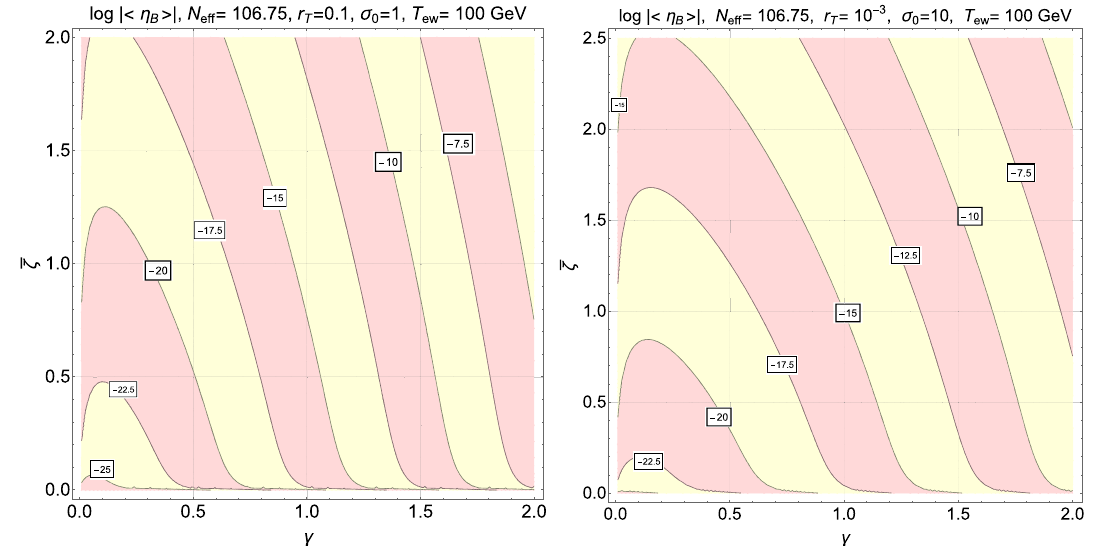
Fig. 3 The contours of the common logarithm of the BAU are illustrated for a fiducial set of parameters assuming T e w = 100GeV; note that r T = 0 . 1 (left plot) and r T = 0 . 001 (right